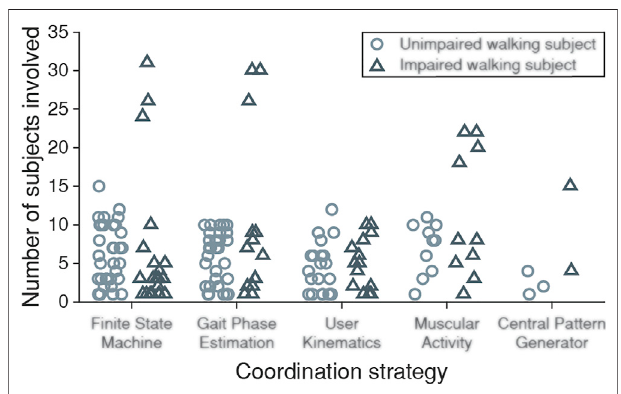
FIGURE12| Numberofsubjectsinvolvedineachreportedexperimental validationgroupedbycoordinationstrategies.Lightcircularmarkersrepresent unimpaired walking subjects while dark triangular markers represent impaired walking